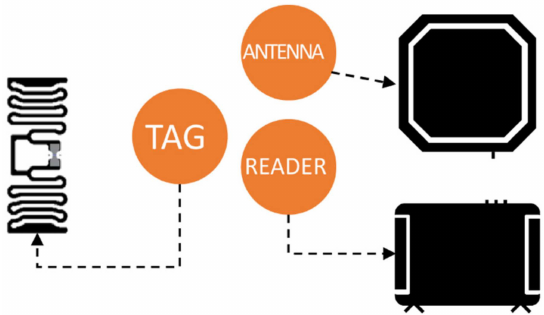
Figure 3. Typical Radio Frequency Identification (RFID) system block scheme.